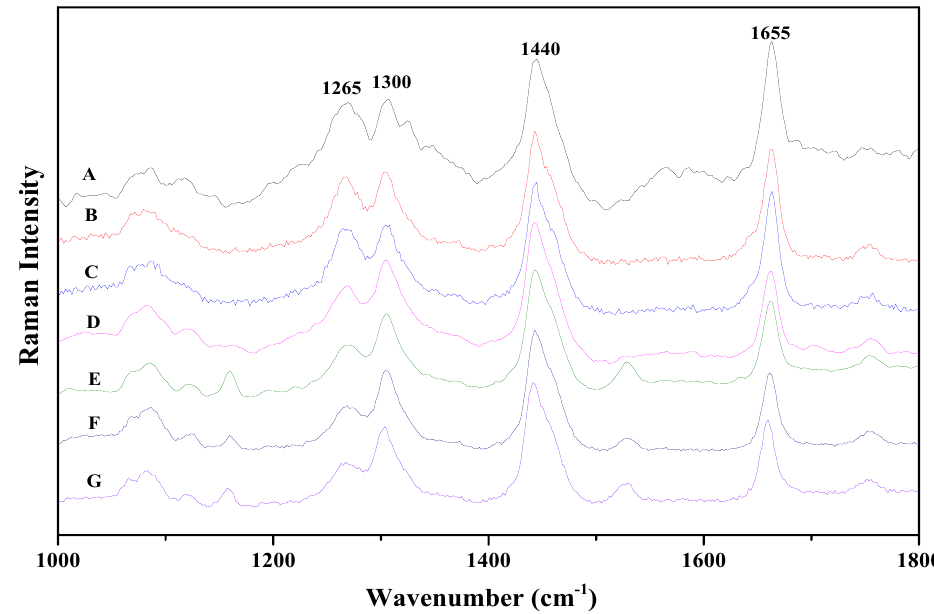
Figure 1. Raman spectra of the seven vegetable oil samples: ( A ) Golden Dragon Fish sunflower seed oil; ( B ) Fortune corn oil; ( C) Golden Dragon Fish corn oil; ( D ) Luhua peanut oil; ( E ) Huilerie Loued olive oil; ( F ) Olivoila olive oil; ( G ) Luhua olive oil. Each spectrum is y -shifted for clarity.